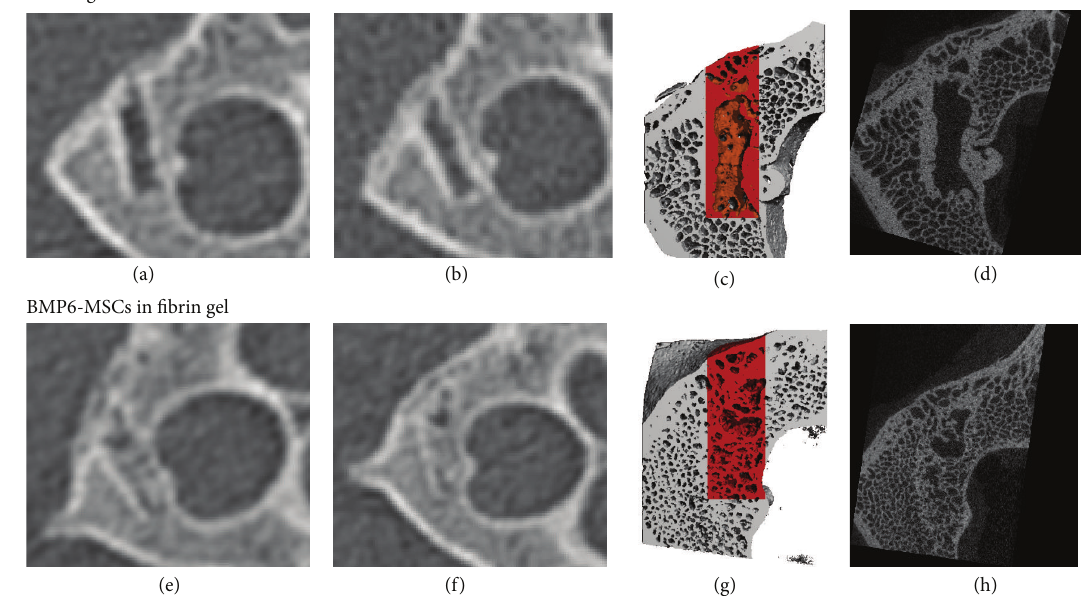
Figure 3: BMP6-MSCs induce vertebral bone repair. Bone regeneration in lumbar vertebral defects was monitored using clinical CT imaging on 6 ((a) and (e)) and 12 weeks after surgery ((b) and (f)). Animals were sacrificed on week 24 (i.e., 6 months) after surgery and excised vertebrae were subjected to 𝜇 CT imaging. Bone formation was quantified based on 𝜇 CT scans (analyzed region is highlighted in red, (c) and (g)). Marked differences in bone regeneration can be seen in defects treated with BMP6-MSCs ((g) and (h)) versus fibrin gel only ((c) and (d)).